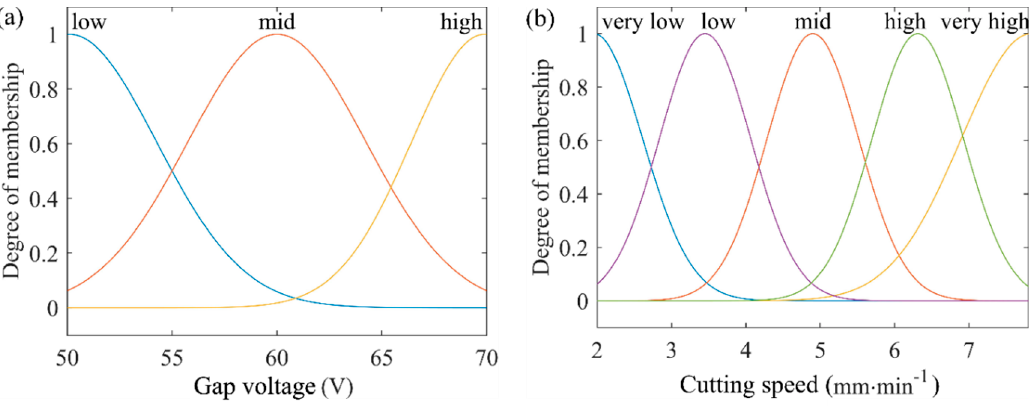
Figure 2. The scheme of fuzzy inference system (FIS) (fuzzy inference system) functioning.